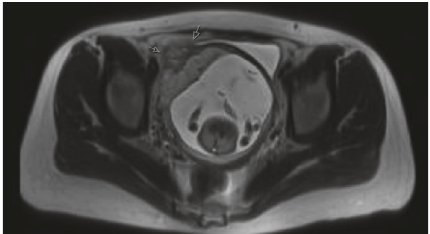
Figure 1: Cross-sectional MRI showing intrauterine pregnancy and CSP with suggestion of placental invasion to the bladder.